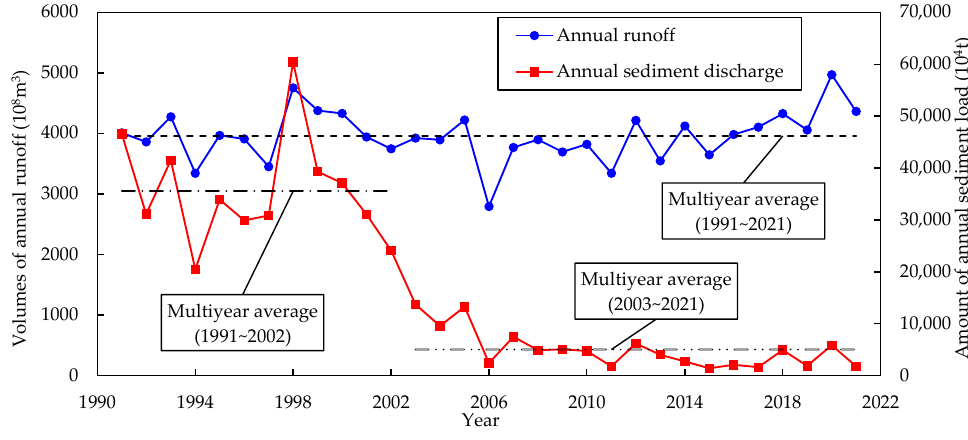
Figure 3. Interannual variation of the annual runoff volumes and sediment load amount at Shashi station.